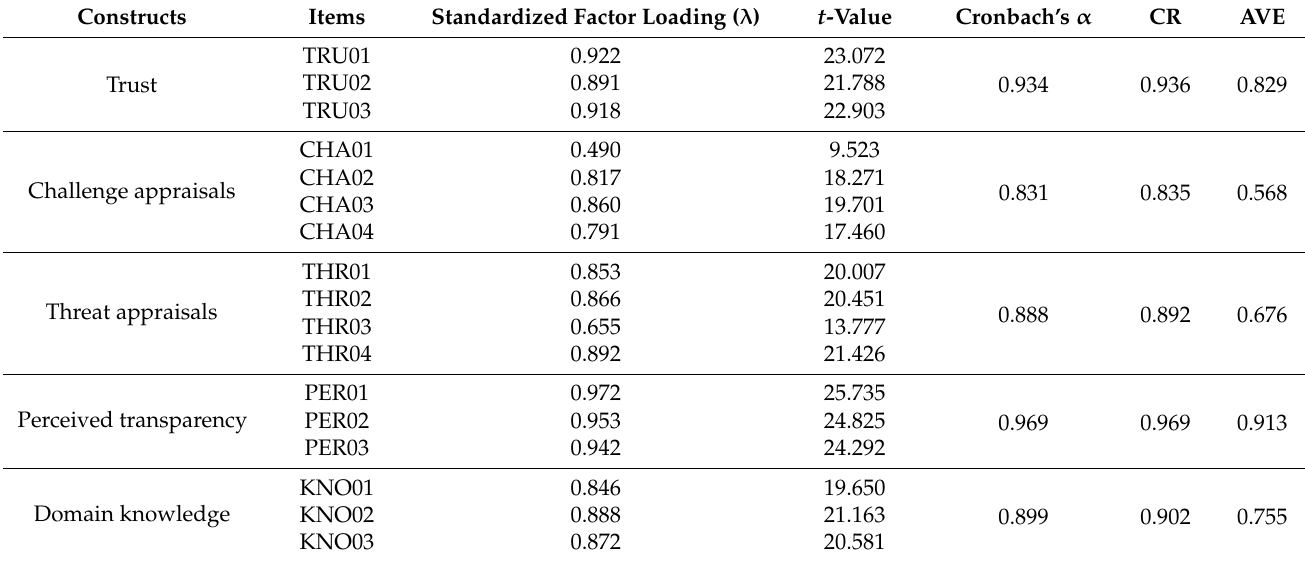
Table 2. Results of reliability and validity analysis (N = 375).